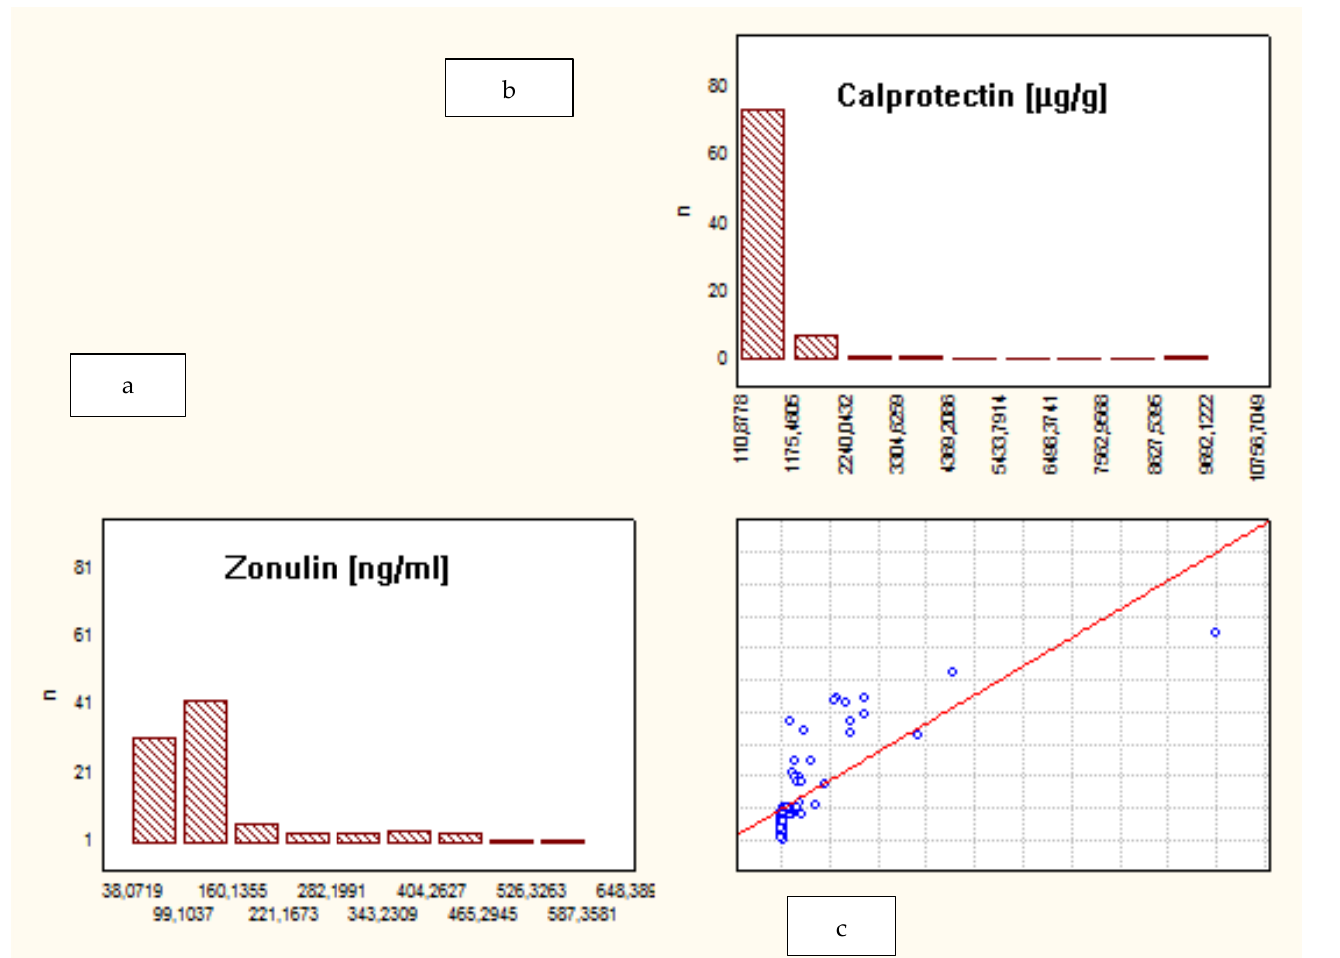
Figure 1. Correlation between fecal zonulin and calprotectin levels in all study participants. ( a ) Levels of fecal zonulin in all study participants (CD, UC, and control); ( b ) levels of fecal calprotectin in all study participants (CD, UC, and control); ( c ) the correlation between levels of fecal zonulin and calprotectin in all study participants.